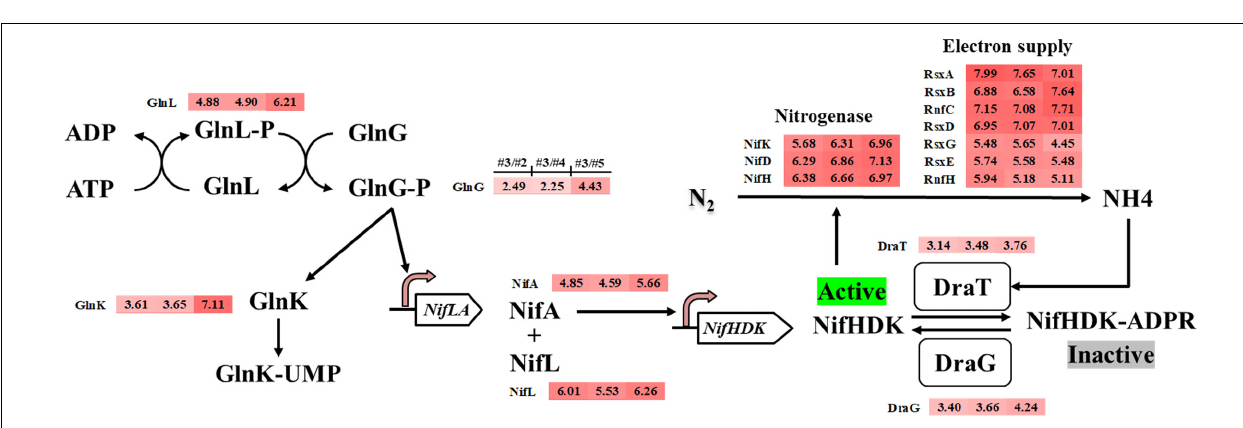
FIGURE 3 | Potential nitrogen fixation regulation system in M. buryatense 5GB1 and genes involved in nitrogen fixation regulation upregulated in #3 condition (CH 4 /O 2 ratio of 0.93) compared with other three conditions of #2, #4, or #5, respectively. The numbers in shadow at right-side of protein name represent the log 2 -based changes of upregulated gene under condition #3 compared to #2, #4, or #5,